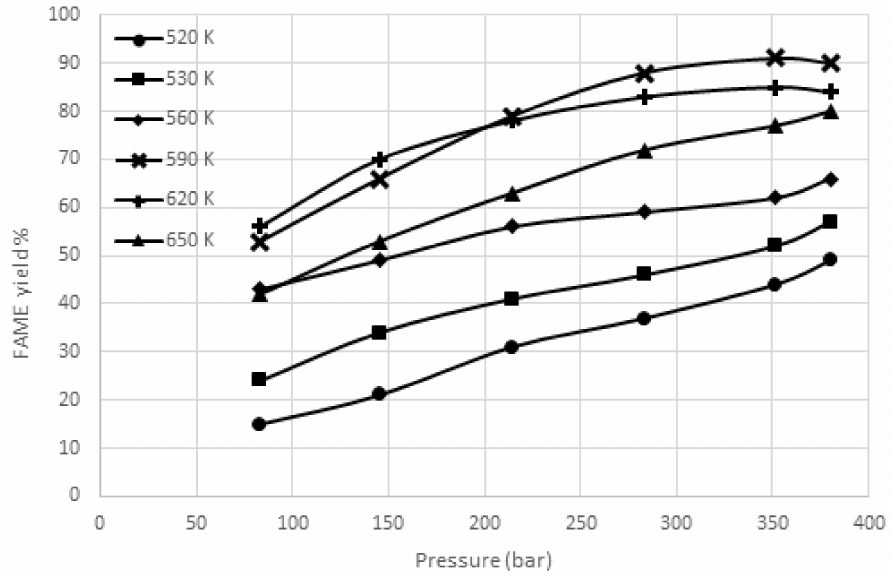
Figure 5. FAME yield (%) at variable pressure (Time = 15 min and Molar ratio = 1:39).